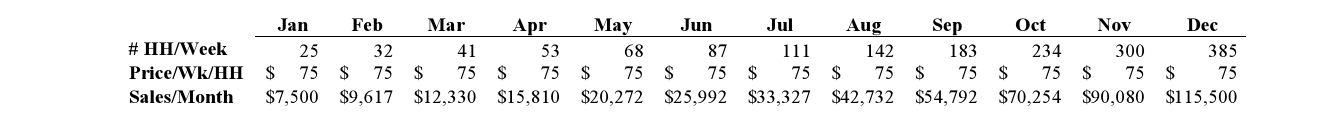
Table 7. Monthly Revenue Projections for the 40291 Zip